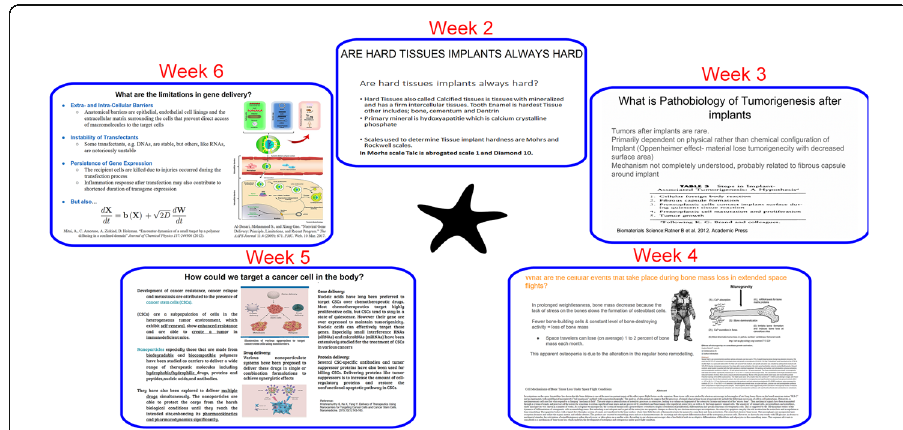
Fig. 5 Evolution of the quality of the co-created content and style throughout the